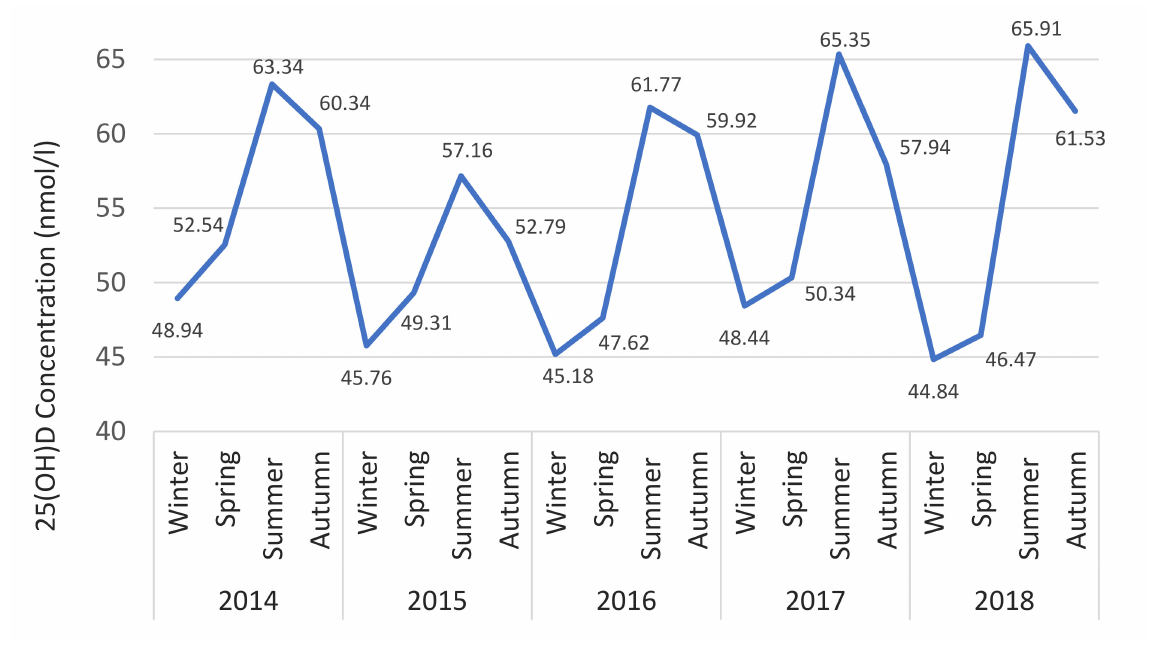
Figure 5. 25(OH)D status versus